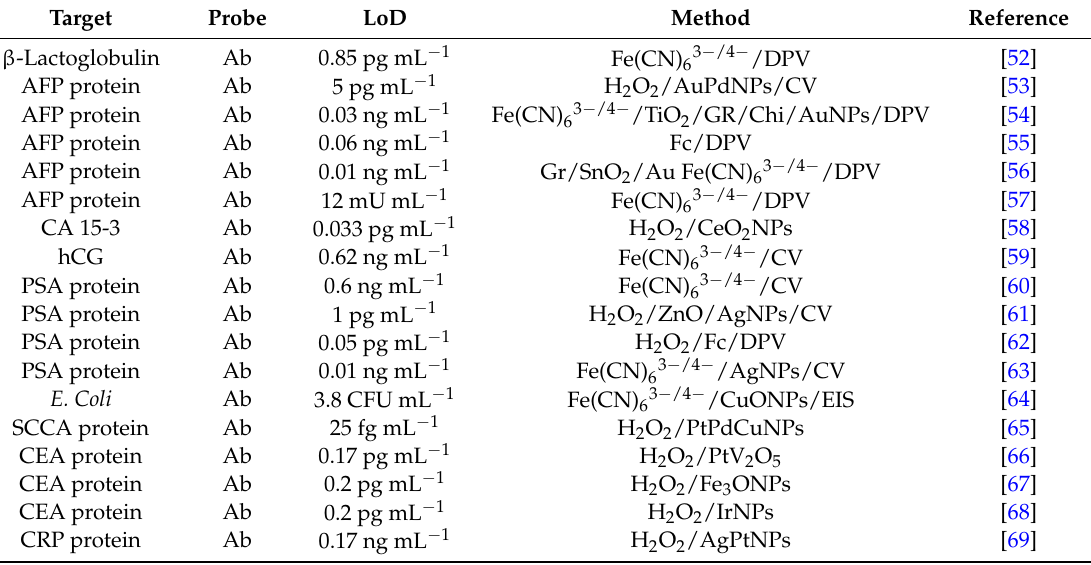
Table 4. Figures of merit of selected enzyme-less immunosensors using graphene and diffusing redox